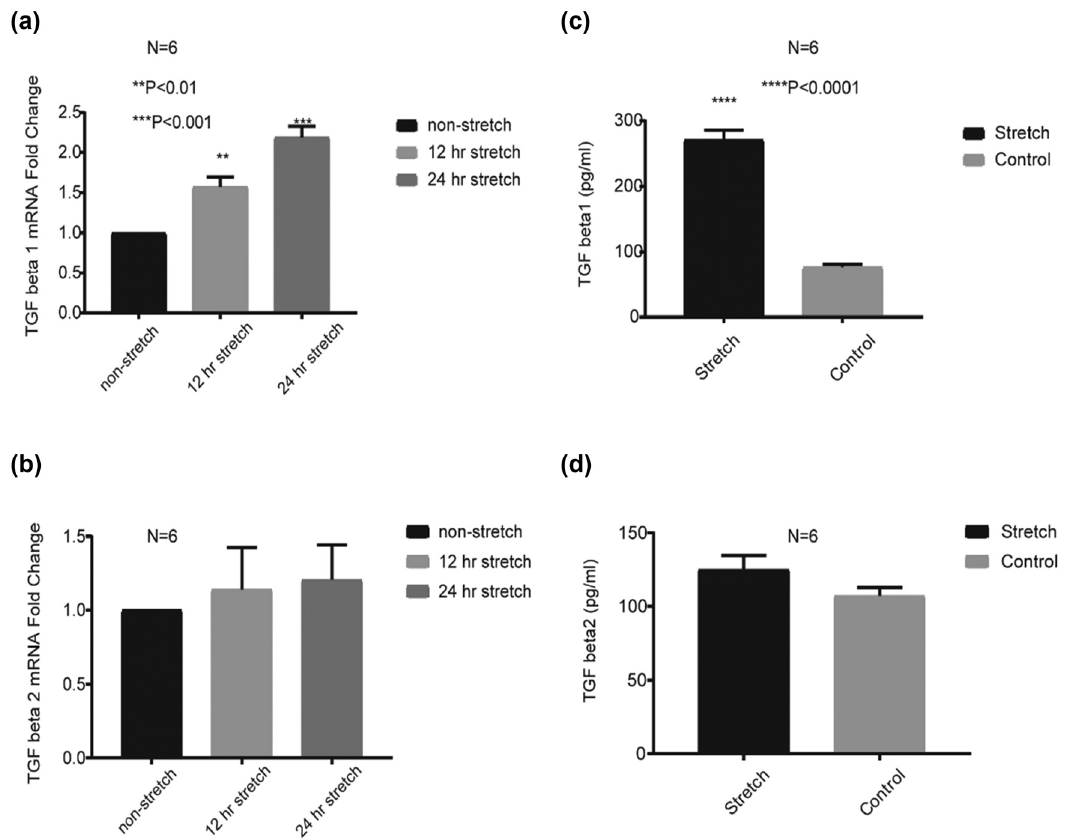
Figure 3: The increased TGF beta1 expression in HUVECs after stretch. ( a and b ) The relative mRNA expression of TGF beta1 and TGF beta2 in HUVECs with 12 and 24 h stretch. ( c and d ) The levels of TGF beta1 and TGF beta2 in HUVECs under 24 h stretch measured by enzyme - linked immunosorbent assay. ** P < 0.01, *** P < 0.001, and **** P < 0.0001 vs the nonstretch or the